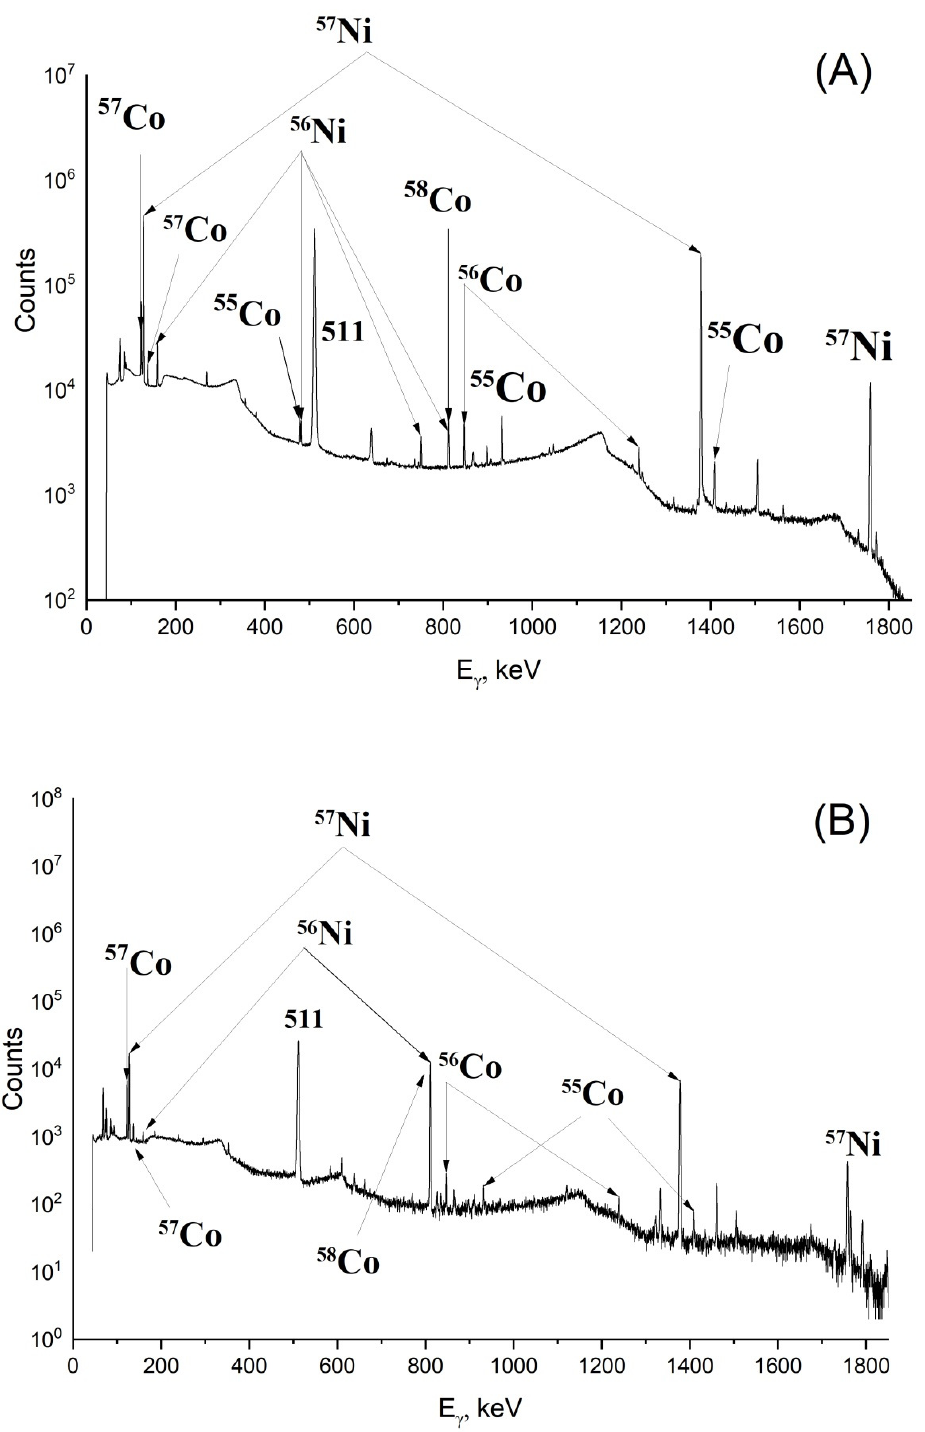
Figure 2. Gamma-spectra of nat Ni irradiated by bremsstrahlung photons with energy up to 55 MeV during 1 h after EOB ( A ), and of irradiated 60 Ni for 19 h after EOB ( B ). The most intense peaks of each isotope are labeled in the figures. Table 1. Yields of photonuclear reactions on nat Ni, 60 Ni (obtained experimentally), and 58 Ni (calcu- lated using yields on nat Ni, 60 Ni nuclei) with maximum energy of bremsstrahlung photons being 55 MeV. Values obtained by TALYS [29] are presented in brackets .